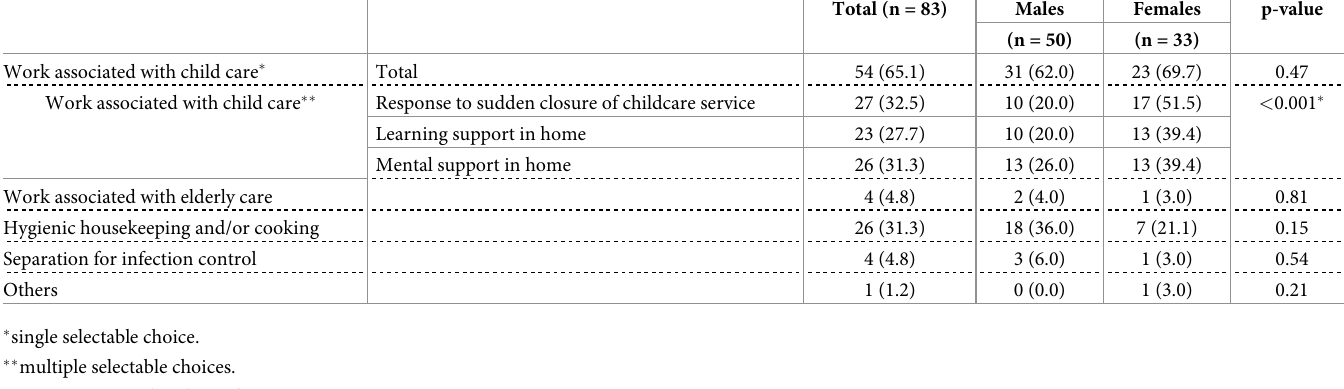
Table 5. Reasons for the increase in the domestic burden of the